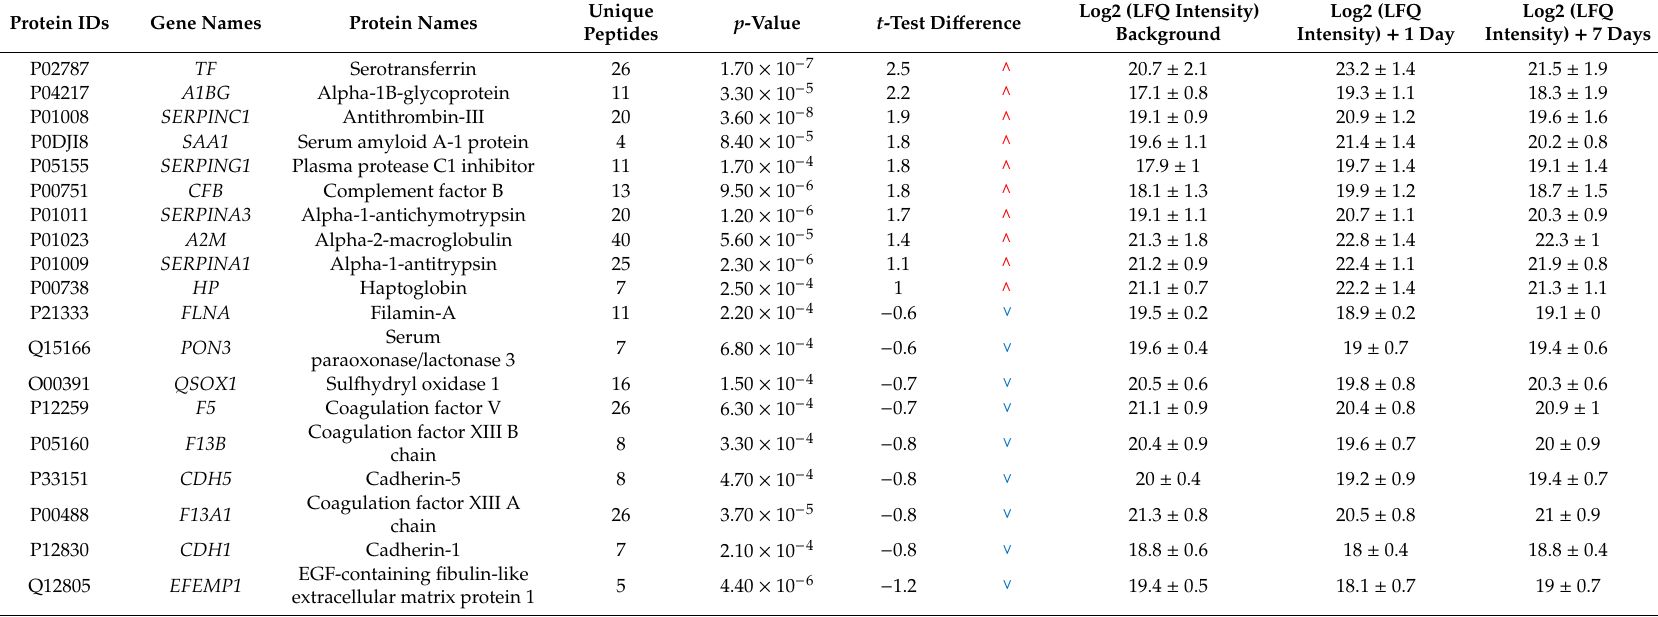
Table 1. The list of proteins significantly changed ( p < 0.01) on the 21st day of the head-down bed rest (HDBR) ground-based experiment with respect to their background levels (the day before the experiment). Proteins were identified by pair-wise comparison (Welch’s t -test). Red/blue symbol—the increase/decrease of the protein level with respect to the background. Table 3. The list of proteins significantly changed ( p < 0.01) on + 1 day after long-term spaceflight. Proteins were identified by pair-wise comparison (Welch’s t -test). Red / blue symbol—the increase / decrease of protein level with respect to the background.